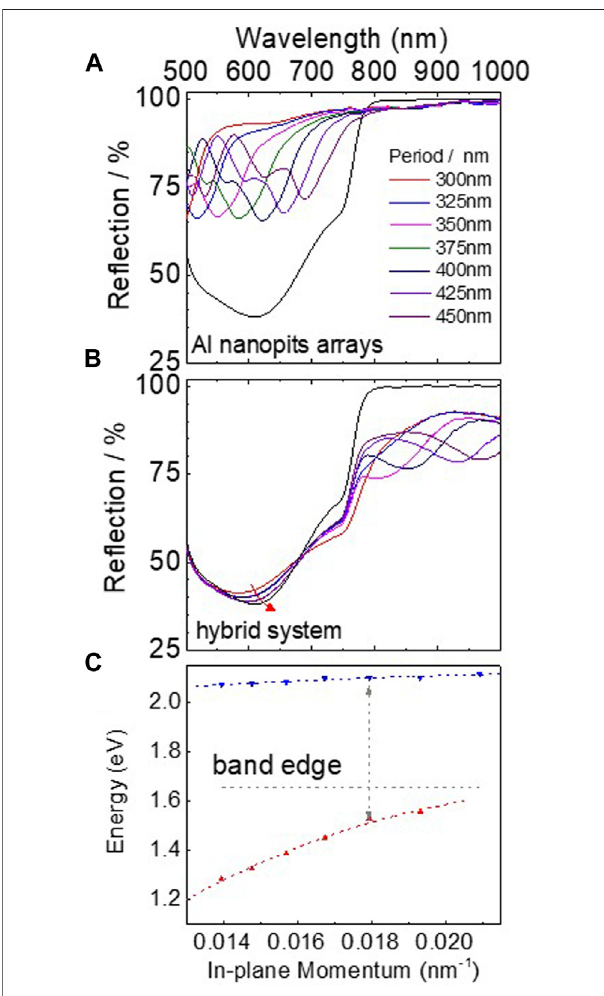
FIGURE 2 | (A) Re fl ection spectra of Al conical nanopit arrays covered by PMMA fi lm. The lattice period is tuned from 300 to 450 nm. The black line shows the re fl ection spectrum of the CH 3 NH 3 PbCl x I 3-x perovskite fi lm on fl at Al fi lm. (B) Re fl ection spectra of the perovskite layer on fl at Al fi lm and conical nanopit arrays. The lattice period is tuned from 300 to 450 nm. (C) Dispersioncurveofhybridfreechangecarrier – SPstrongcoupledsystem.The horizontal dashed line shows the band edge of the CH 3 NH 3 PbCl x I 3-x perovskite fi